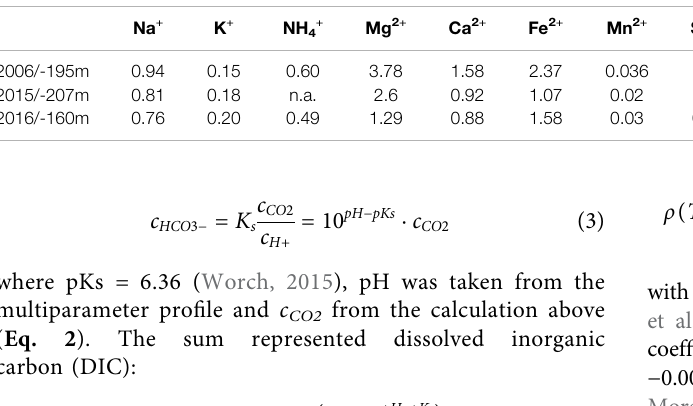
TABLE 1 | Concentrations of solutes in Lake Nyos as reported by Kusakabe et al. (2008) (K) listed in Sanemasa et al. (2017) and by Anazawa et al. (2019) (A); n.a. (cid:2) not